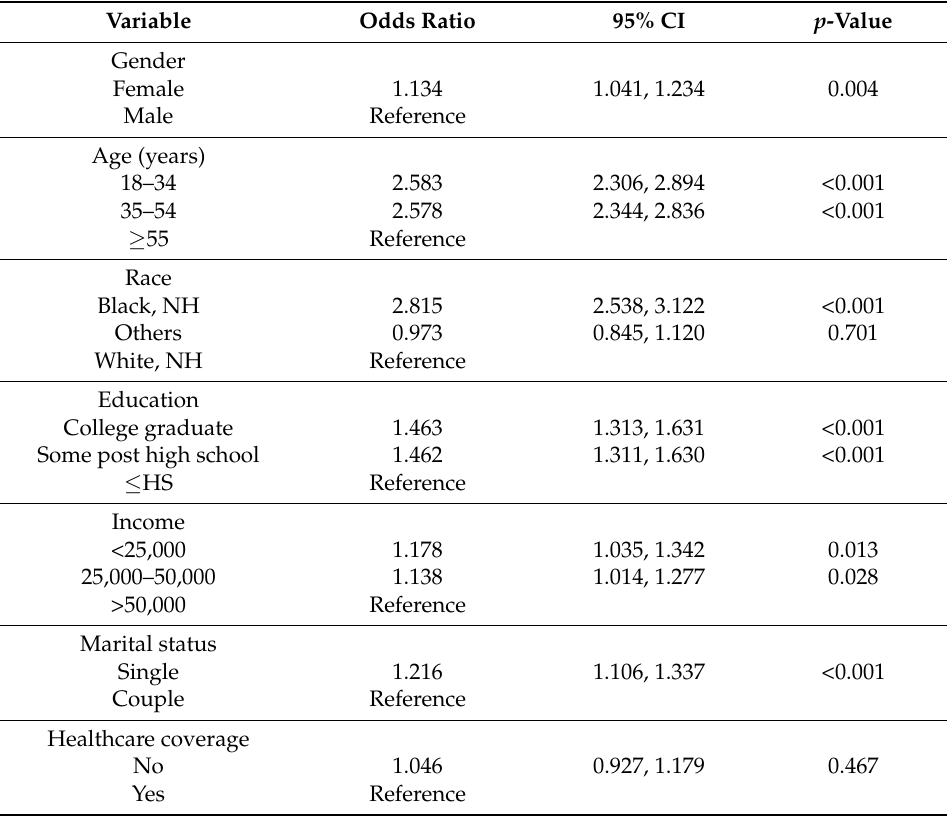
Table 3. Logistic regression analysis of socio-demographic factors associated with having ever been tested for HIV in Georgia: BRFSS